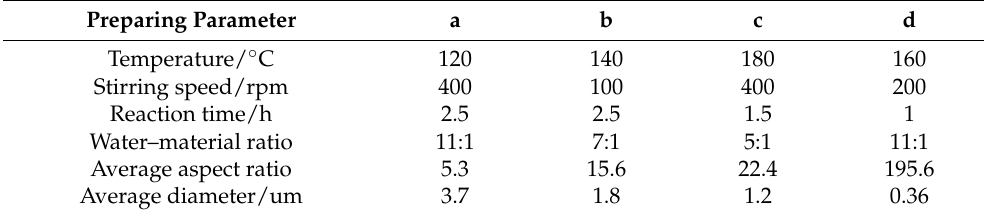
Table 3. The preparing parameters of CSHW.